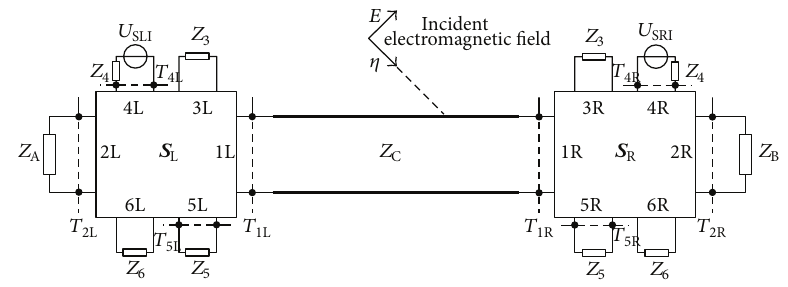
Figure 11: The equivalent circuit model of DDMCI test method.